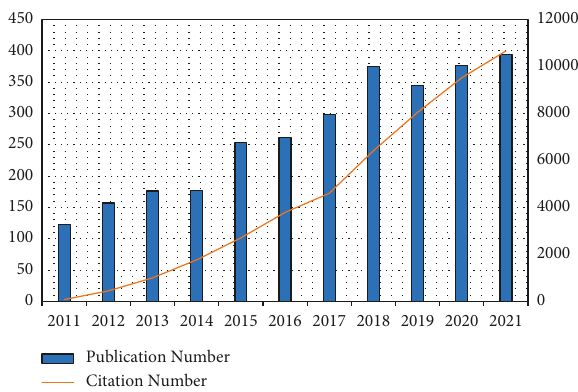
Figure 1: The number of publications about dynamic complex network research from 2011 to